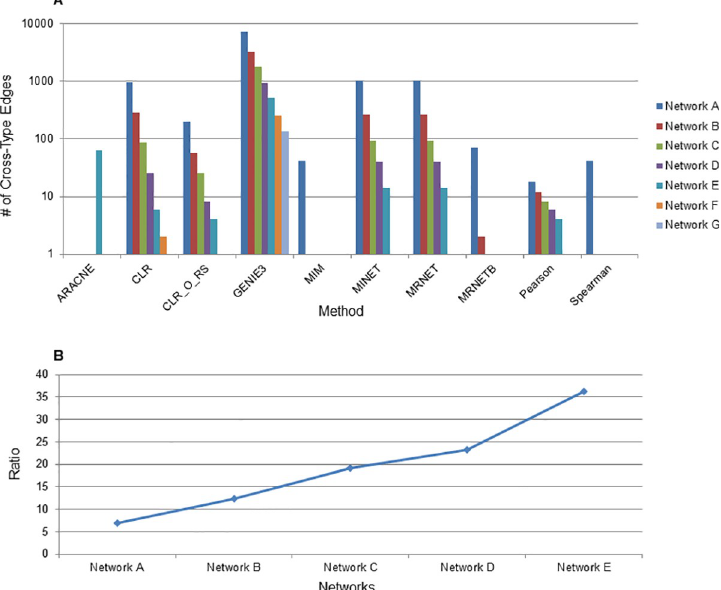
Fig 2. Comparison of network inference method’s ability to generate cross-type edges. (A) Networks were made with several different methods and edge cutoffs were chosen so that all networks of a particular letter are the same size across inference methods. The number of Cross-type edges for each network is shown on the y-axis and the methods on the x-axis. CLR_O_RS indicates the original CLR algorithm with resampling to distinguish it from the version of CLR used in the MINET package. The ARACNE method removes edges of low association as part of its methodology and thus only smaller networks containing high scoring edges are retained with ARACNE. (B) The fold increase in Cross-type edges inferred by the GENIE3 method compared to the MINET method (the next best method at creating Cross-type edges) is shown. For networks F and G MINET did not draw any Cross-type edges and so these ratios are not displayed.